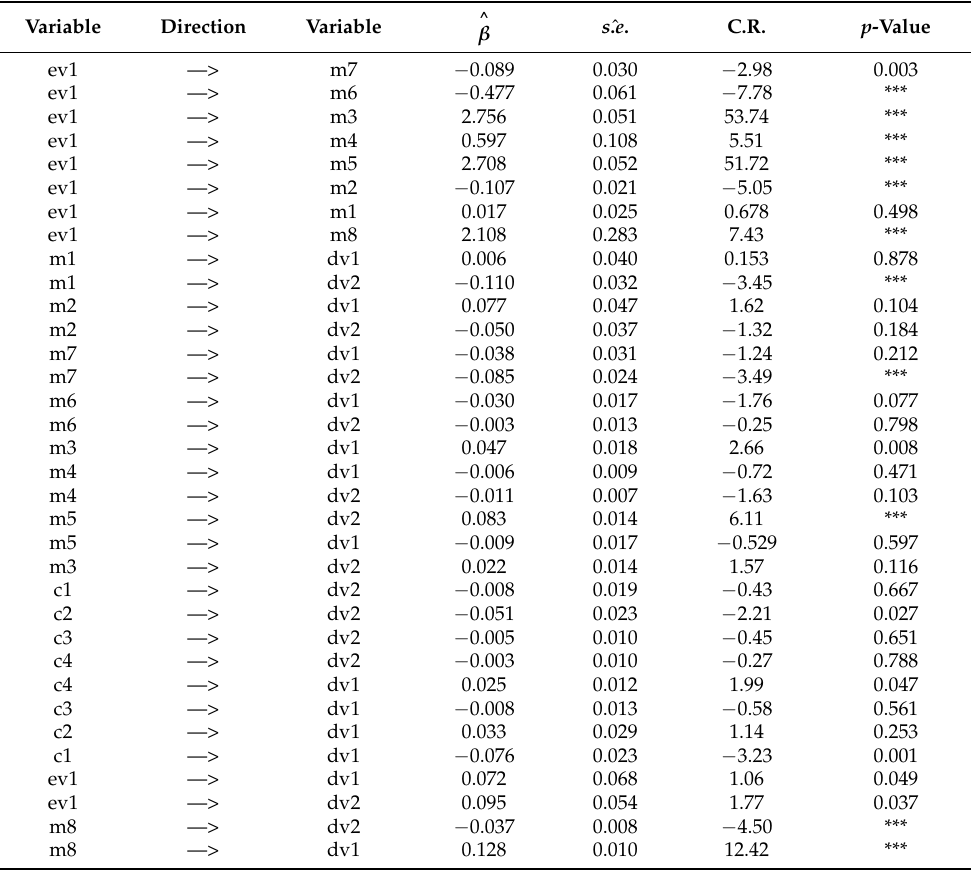
Table 8. Estimated parameters of the mediation (path) model.